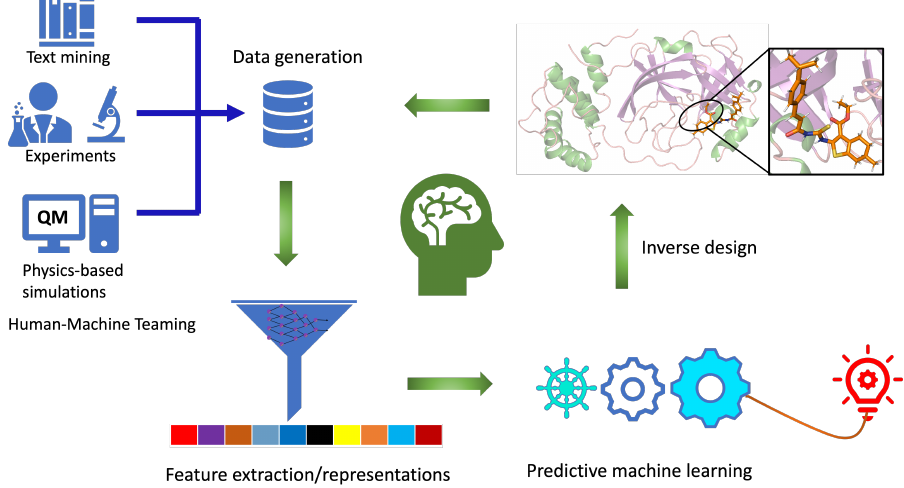
Figure 1. Closed-loop workflow for computational autonomous molecular design (CAMD) for medical therapeutics. Individual components of the workflow are labeled. It consists of data generation, feature extraction, predictive machine learning and an inverse molecular design